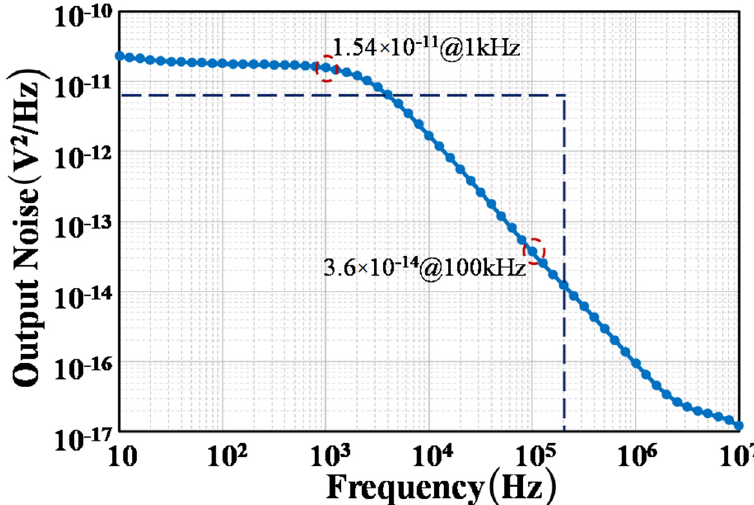
Figure 9. Output noise of proposed envelope detector in high-sensitivity (HS) mode.